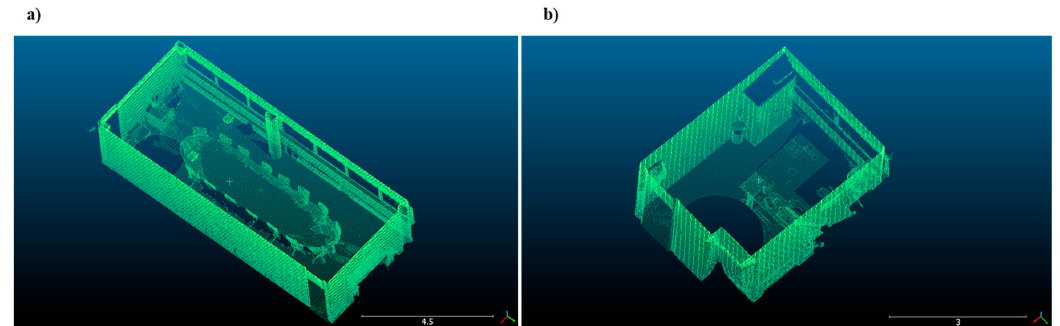
Figure 6. Three-dimensional view of the point clouds used as case study 1 and case study 2: ( a ) videoconference room; scale bar of 4.5 m; ( b ) office; scale bar of 3.0 m. The ceiling is removed in all views to facilitate visualization.